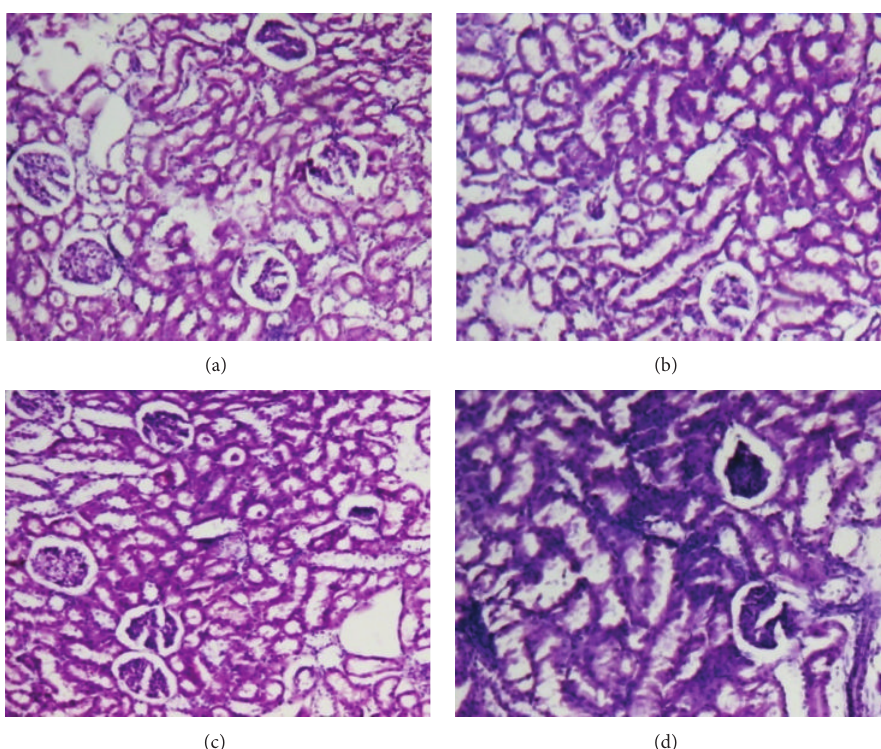
Figure 2: Histology of kidney (H&E, 100x) of control and OSE-treated animals. (a) Section of kidney from control animal showed normal size of glomeruli with normal tubules; ((b), (c), and (d)) kidney from OSE (200, 400, and 800 mg/kg)-treated animals exhibit normal size of glomeruli with normal